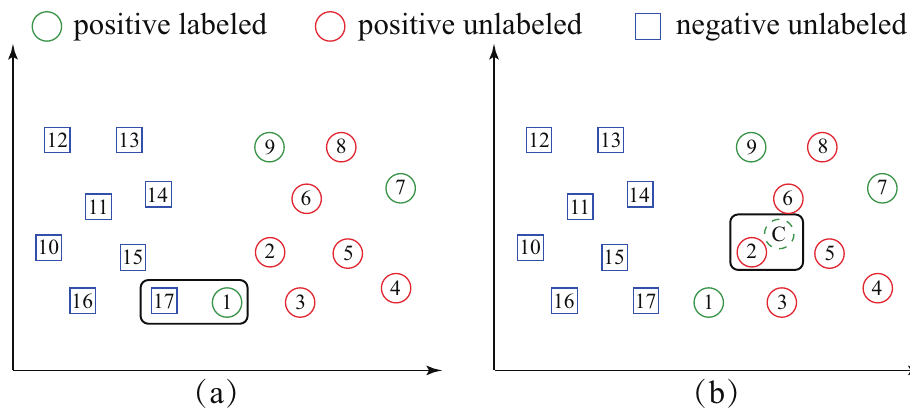
Figure 2. An illustration of the difference between ST based methods ( a ) and our ST-average method ( b ). ST labels the unlabeled data (square-17) which is closest to PL set while ST-average labels the unlabeled data (circle-2) which is closest to the average sequence of the PL set.